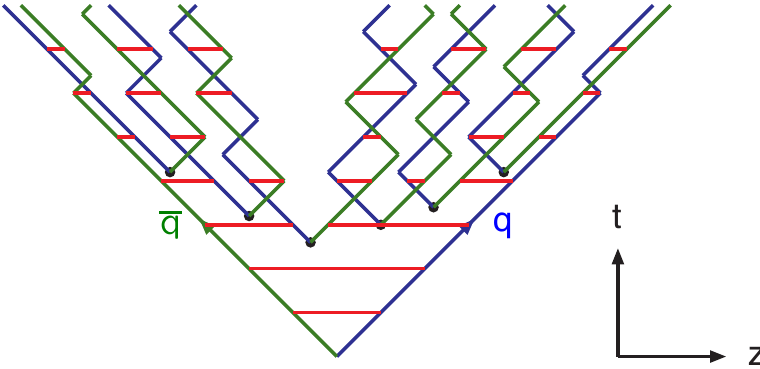
Figure 4. An illustration of the string hadronisation picture in the Lund